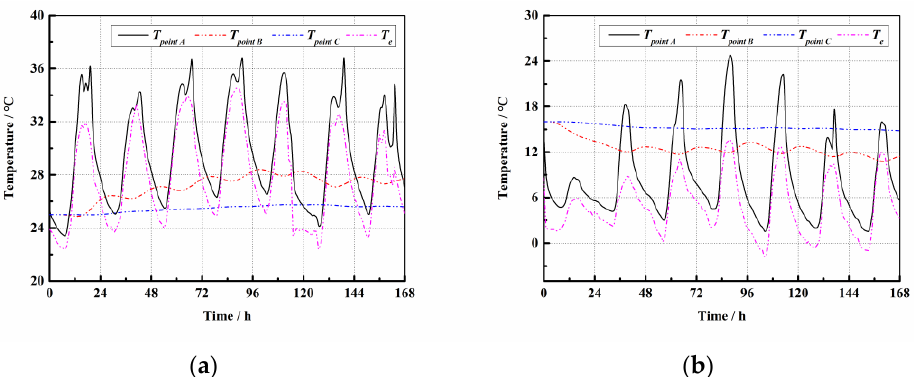
Figure 6. The temperature distribution of the rammed earth wall: ( a ) the temperature distribution of the rammed earth wall in summer; ( b ) the temperature distribution of the rammed earth wall in winter.